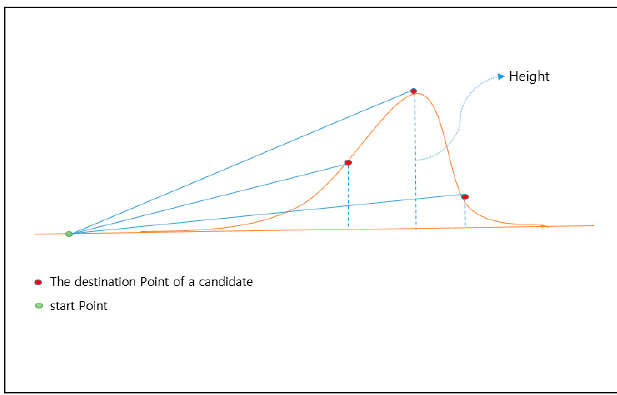
Figure 13. Inducing the shortest distance.